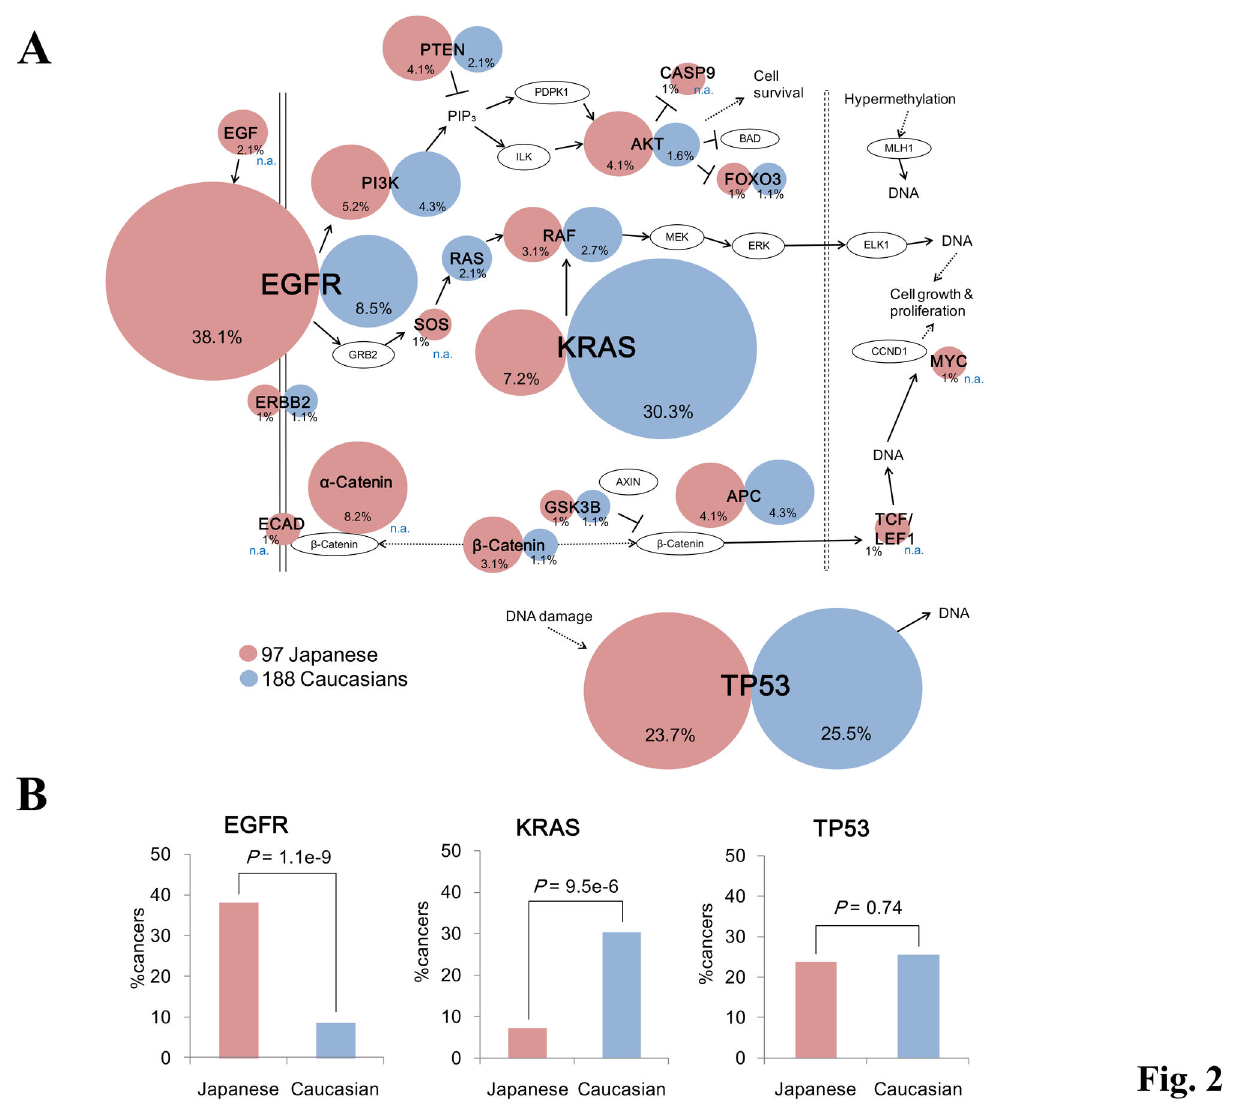
Figure 2. The EGFR/Ras pathways in Japanese and Caucasian populations. ( A ) Mutation patterns in the endometrial cancer pathway that was detected in the enrichment analysis are shown. The size of the circle represents the population of the cancers harboring the SNVs in the corresponding gene (percentage is also shown in the margin). SNVs in this study and the external dataset in Caucasian populations are shown in red and blue circles, respectively. n.a.: mutation frequencies were not available. ( B ) Comparison of mutation ratio of EGFR, KRAS and TP53 genes among both datasets. The p-values were calculated by two-sample test for equality of